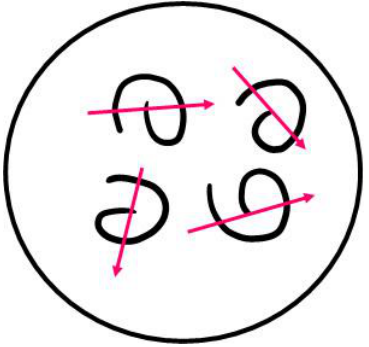
Figure 9. Structure model for raw undispersed polyaniline.